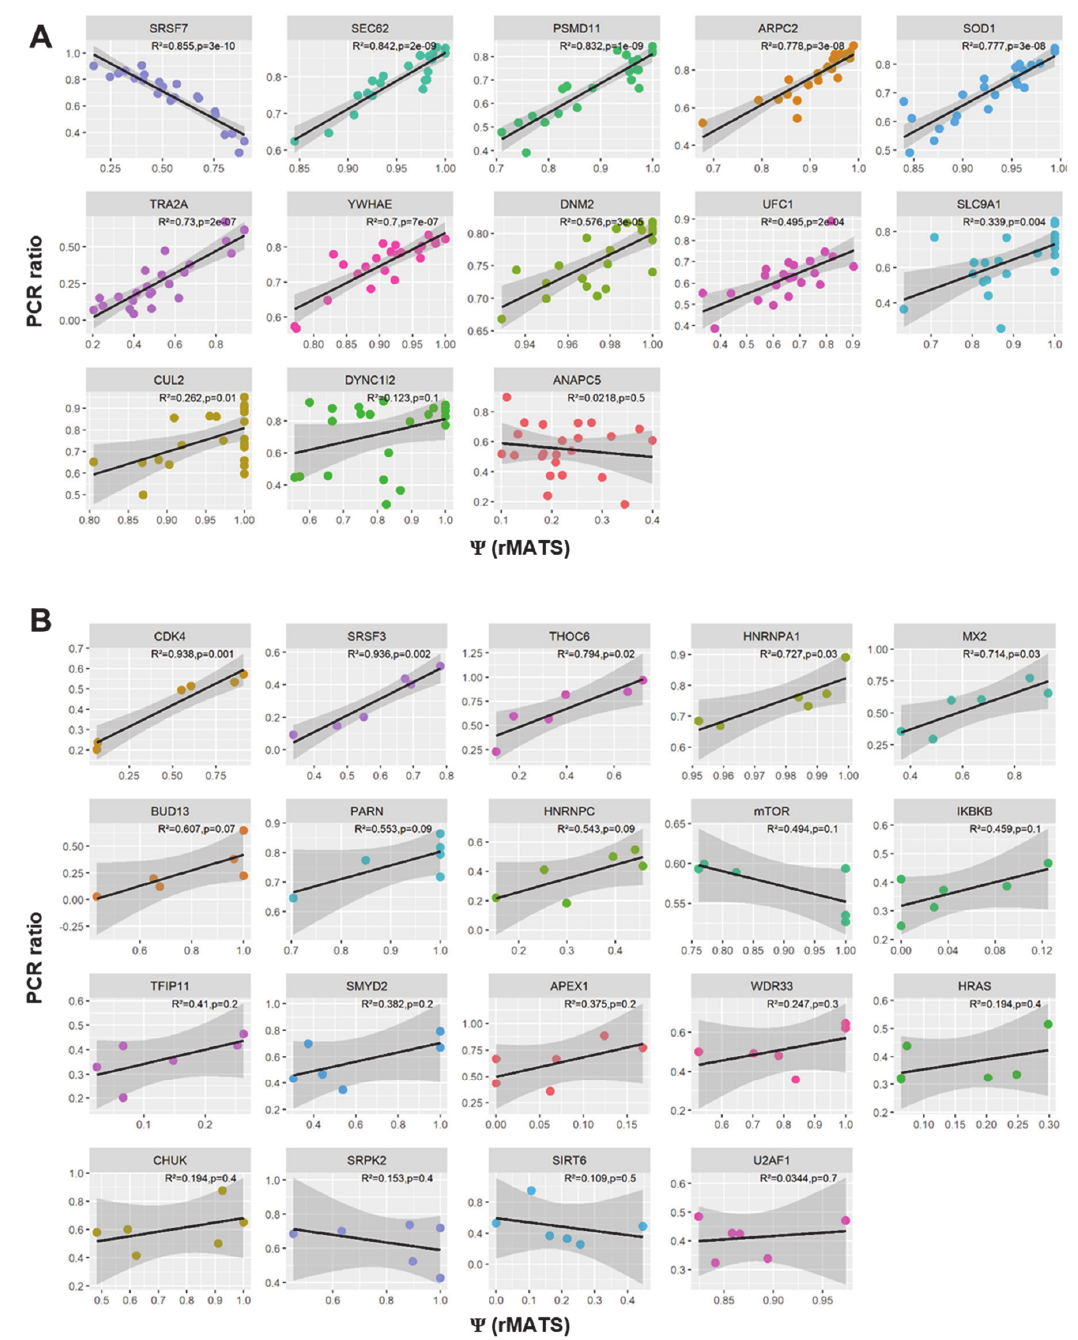
Figure A3. Correlation of rMATS-derived Percentage Spliced-In ( Ψ ) and PCR ratio of genes validated by RT-PCR. ( A ) 13 genes validated for BCP-ALL dataset. ( B ) Nineteen genes validated for T-ALL dataset. Genes are shown in decreasing order of the R 2 coe ffi cient. Adjusted p -values are